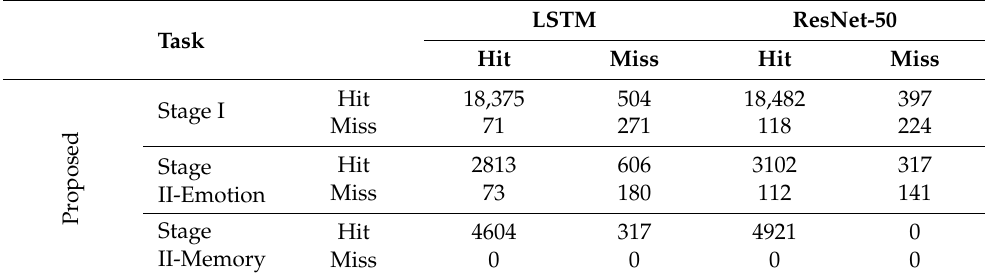
Table 5. Diversity of classifiers